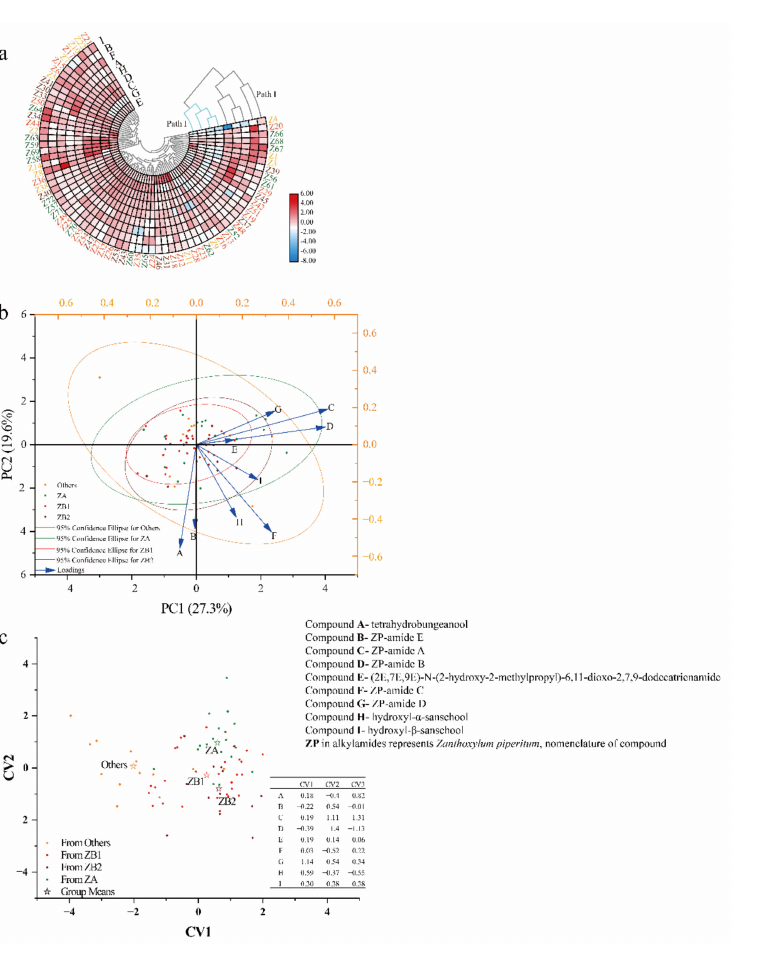
Figure 4. Geographical differentiation of prickly ash pericarps from 72 plantations based on alky- lamide profiling of pericarps: ( a ) cluster heat map, ( b ) loading plot and score for the first two principal components, and ( c ) discriminant analysis. PC indicates principal component; CV stands for canoni- cal variable; ZA ( n = 18) represents green pericarps derived from the species of Zanthoxylum armatum ; ZB1 ( n = 28) represents red pericarps derived from the species of Z. bungeanum from Hancheng; ZB2 ( n = 13) represents red pericarps from Fengxian; and Others ( n = 13) represents the rest of the samples that have red pericarps, and is a mixture of species excluding Z. bungeanum